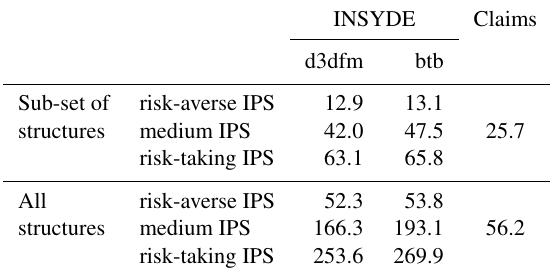
Table 8. Comparison of damage claims and estimates based on hydrodynamic (d3dfm) and bathtub (btb) flood depth estimates [EUR million].